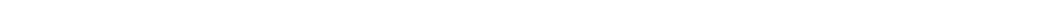
Fig. 4 SC PV + neurons transmit threat-relevant visual signals to the PBGN and LPTN. a Diagram showing AAV-DIO-GCaMP6m injection into the SC followed by optic fi ber implantation above the SC, PBGN or LPTN of PV-ires-Cre mice. b Micrographs of the SC showing expression of GCaMP6m in PV + neurons. Scale bars, 0.5 mm (left) and 25 μ m (right). For single-channel micrographs and quantitative analyses, see Supplementary Fig. 5a. c Validation of fi ber photometry by simultaneous recording of action potentials (APs) and Ca 2 + transients from SC PV + neurons in SC slices. The evoked APs (red) and Ca 2 + transients (green) were synchronized with fi eld stimulation train. d Schematic diagram showing in vivo fi ber photometry to record Ca 2 + transients in anesthetized mice. A virtual soccer ball moving in six orthogonal directions (±X, ±Y, ±Z) was displayed on an oblique screen facing directly to the eye axis. e Fiber tracks above the GCaMP6 + axon terminals in the PBGN (left) and LPTN (right). Scale bars, 0.2 mm. f − i Averaged peri-stimulus time course of Ca 2 + transients from SC PV + neurons of nine mice to the looming ball with controlled velocity ( V = 2 or 5 m s − 1 ) and diameter ( D = 0.4 or 0.8 m). For responses in other directions, see Supplementary Fig. 5b. j , k Correlation analyses of response onset time ( j ) or peak time ( k ) vs. square root of D/V of the looming ball. l , m Time course of Ca 2 + transients from PV + axon terminals in the PBGN ( l ) and LPTN ( m ) to the looming ball ( D = 0.8 m, V = 2 m s − 1 ). n Comparison of response onset time (left) and peak time (right) between SC PV + neurons and their axon terminals in the PBGN or LPTN. Cloudy area in ( f − i , l , m ) indicates SEM of the averaged data. Data in ( j , k , n ) are means ± SEM (error bars). Statistical analysis was Student ’ s t test (n.s. P >